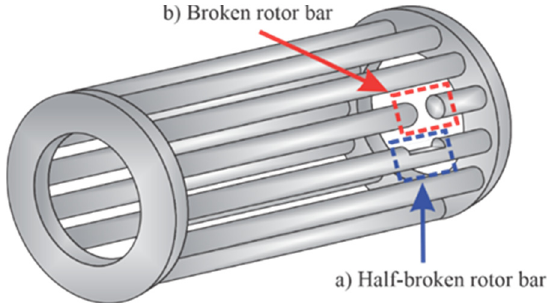
Figure 8. Crack deep for: ( a ) HBRB condition; and ( b ) BRB condition.